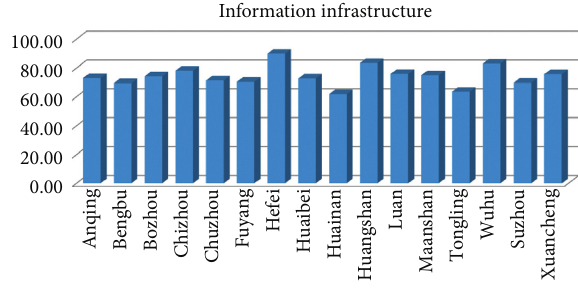
Figure 12: Information infrastructure.